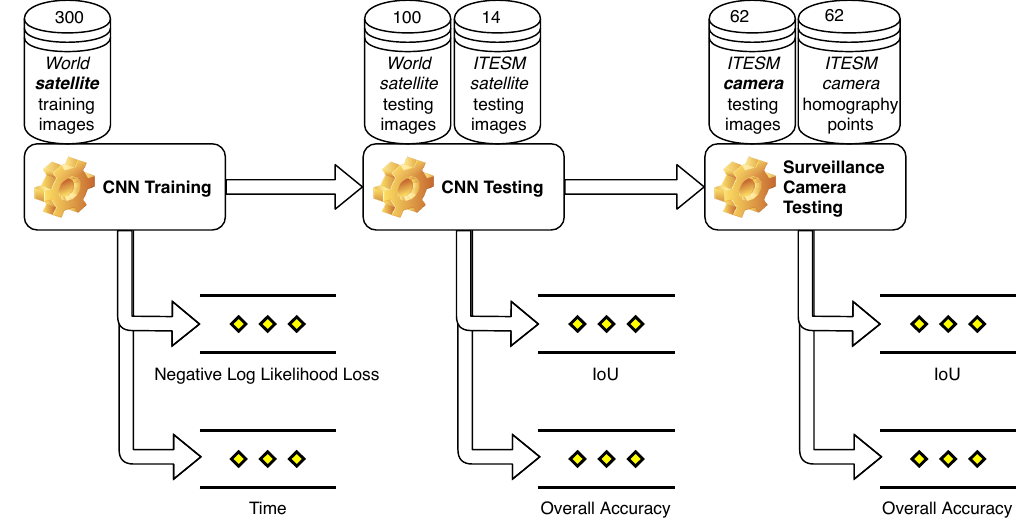
Figure 5. APKLOT dataflow between training, testing and translating the results to the surveillance camera image. The proposed metrics for measuring success are shown below each step. These metrics are discussed under the Evaluation Protocol section (Section